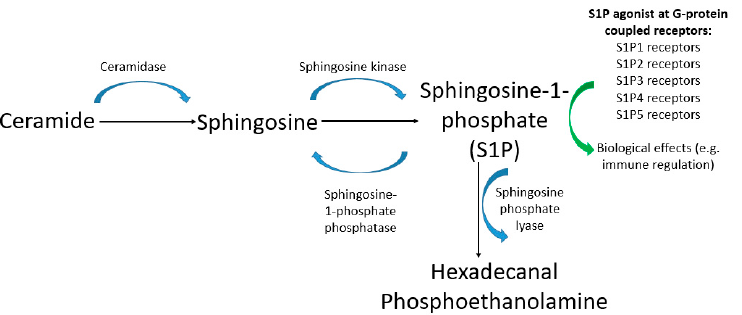
Figure 2. Simplified pathway diagram showing inter-relationship between ceramide, sphingosine, and sphingosine-1-phosphate. Immune responses can include effector T cells entering systemic circulation in response to S1P binding to S1P1 receptors [28].